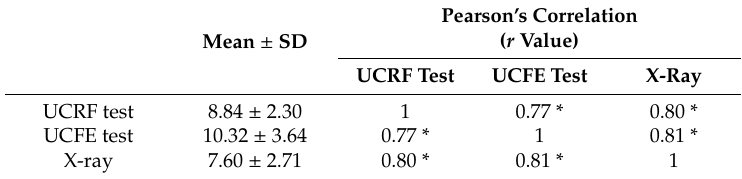
Table 1. Pearson’s correlation of upper cervical flexion angles between three